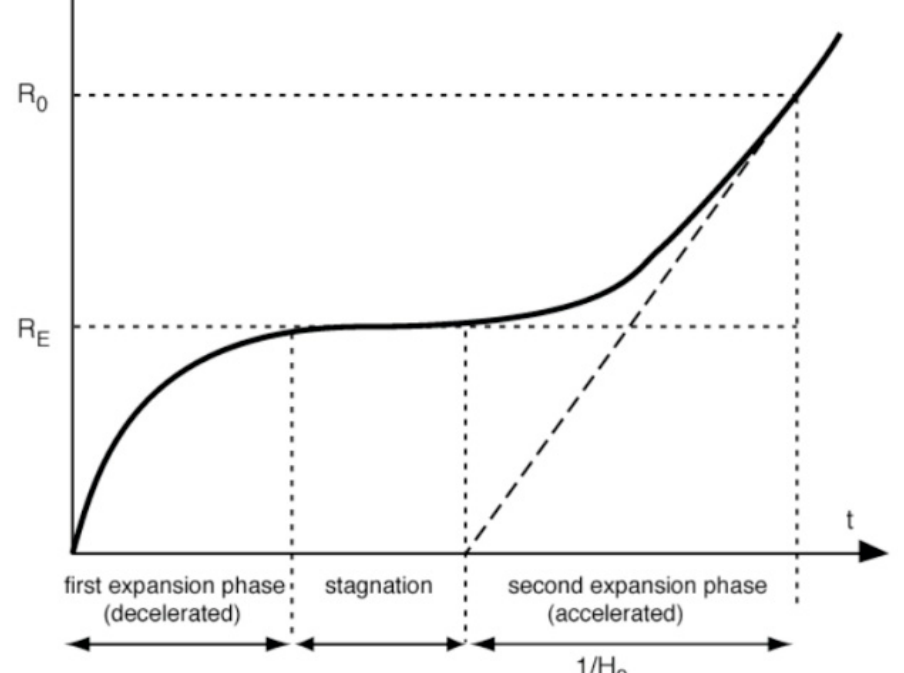
Figure 2. This graph shows how the cosmic distances change as a function of time in the universe model which Lemaître presented in 1931. The quantity 1/H 0 , where H 0 is the present value of the Hubble parameter, is the so-called Hubble age of the universe. It is the age which the universe would have had if it expanded with the present velocity during it whole history. The Lemaître-universe started with an explosion of space and went into a first era with rapid expansion. This was then retarded by the attractive gravity due to matter. The universe then entered a period with low expansion. In this era, there is close to equilibrium between the attractive gravity due to matter and the repulsion due to the cosmological constant. The duration of this so-called “hesitating era” could be determined so that the age of the universe model is in agreement with observational data by adjusting the magnitude of the cosmological constant. The universe finally entered the present period with accelerated expansion [25].